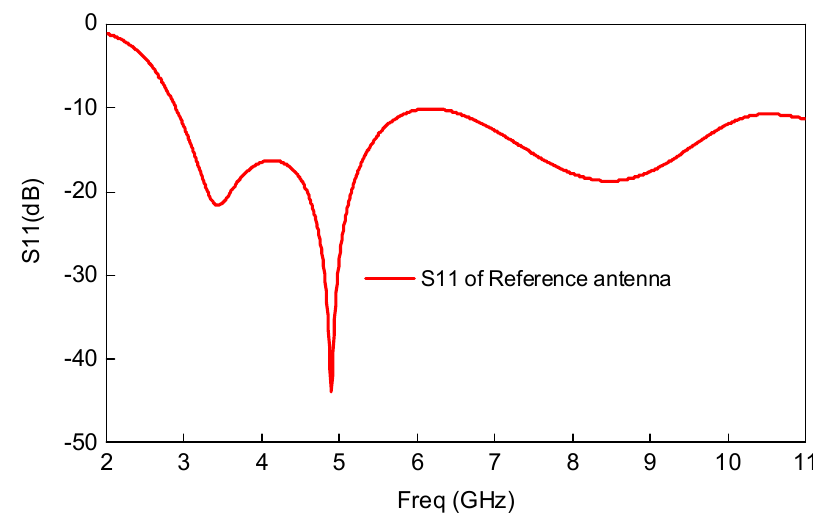
Figure 3. The reflection coefficient of the reference UWB antenna.